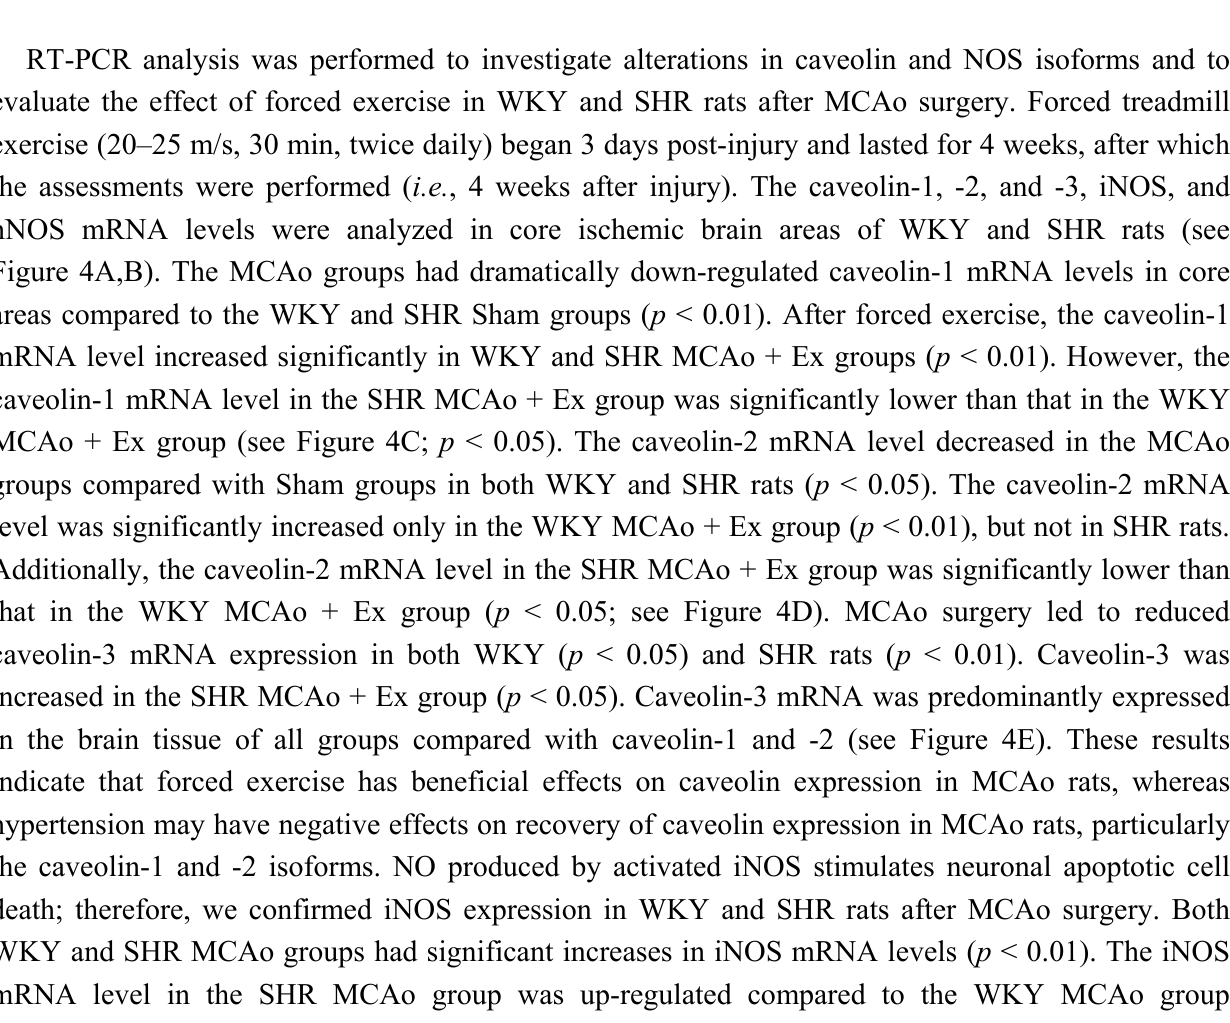
All data were represented by median value and range; ** p < 0.01 between Sham and MCAo (Mann-Whitney two